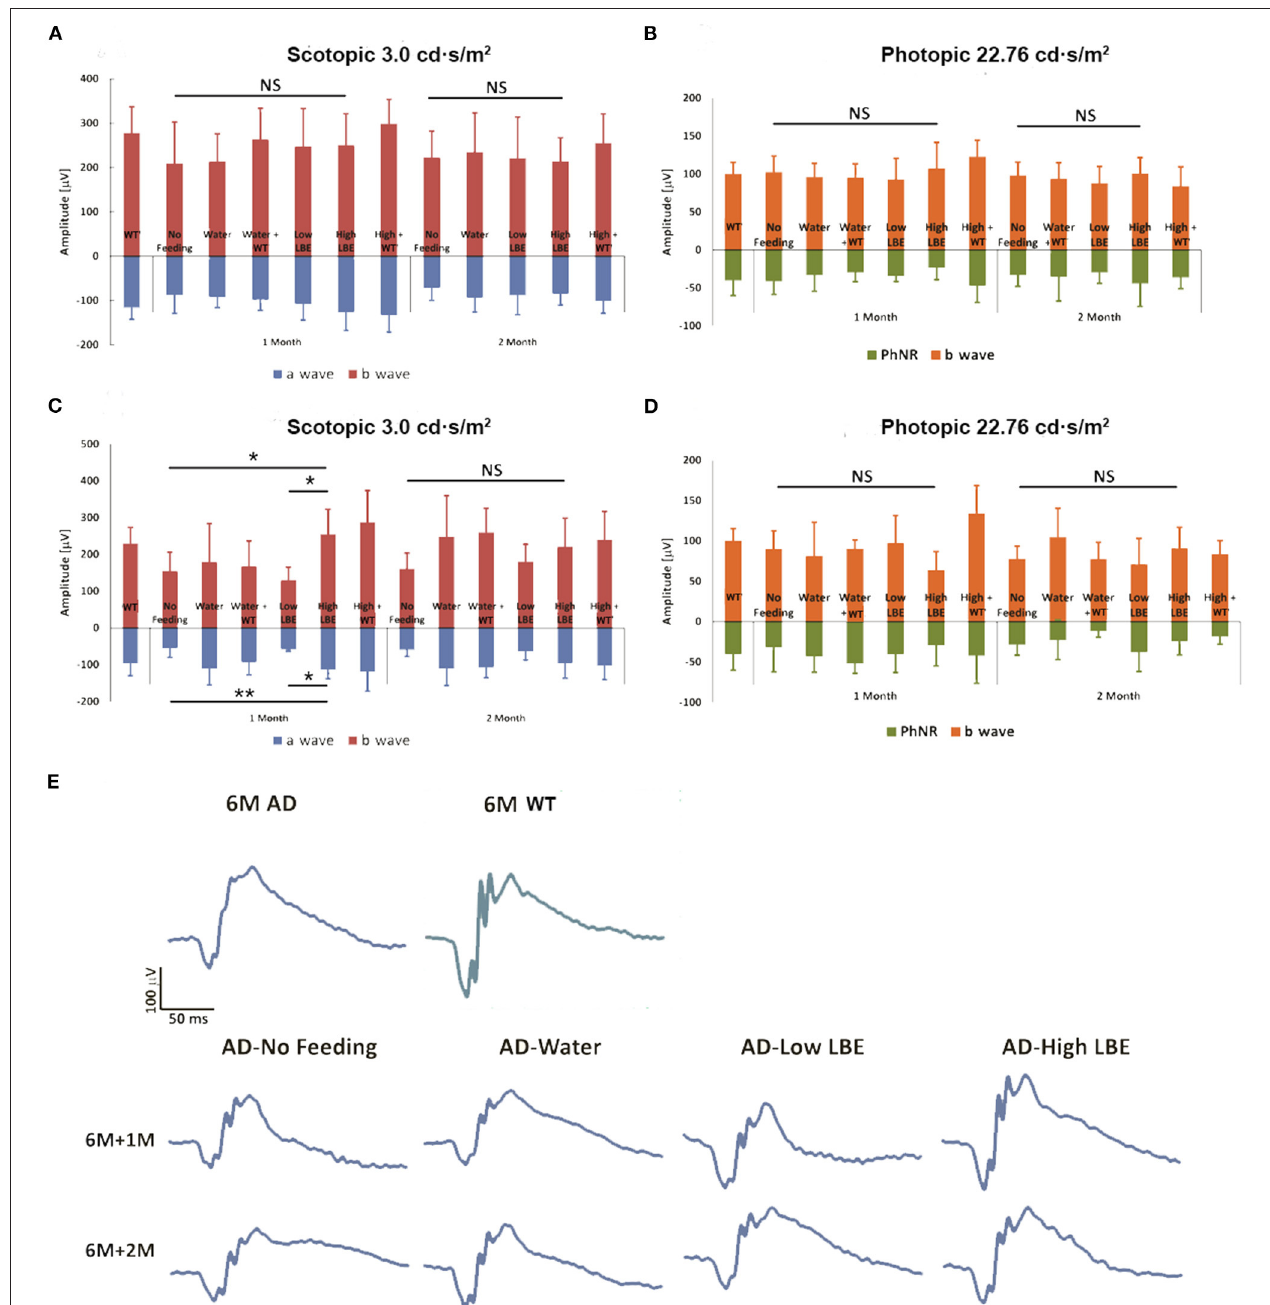
FIGURE 2 | Effect on retinal function of LBE oral feeding started at different ages. LBE feeding started at 4 months or 6 months of age in both non-Tg and 3xTg-AD mice. For two months, two doses [low (200 mg/kg) or high (2 g/kg)] of LBE were given daily, while water served as the control and non-feeding as the age-matched AD control. LBE feeding from age 4 months showed a trend toward better scotopic retinal response for both a-wave and b-wave in 3xTg-AD mice (A) . When started at 6 months of age, high dose LBE feeding of 3xTg-AD mice for 1 month showed significantly higher retinal response to scotopic light intensity (3.0 cd · s/m 2 ) compared to 3xTg-AD mice given only water (C) . Photopic b-wave and PhNR, indicating the function of the inner nuclear layer and RGCs, showed no differences among all the groups (B,D) . * p < 0.05, ** p < 0.01; NS, no significant change. Typical ERG wave forms of various groups at 1 month and 2 months after the start of feeding (E)